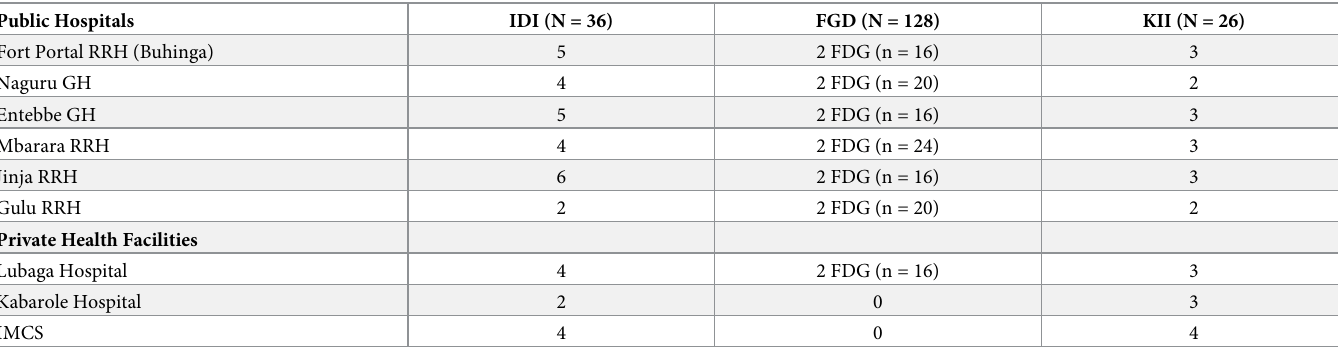
Table 1. Selected health facilities, interviews and discussions